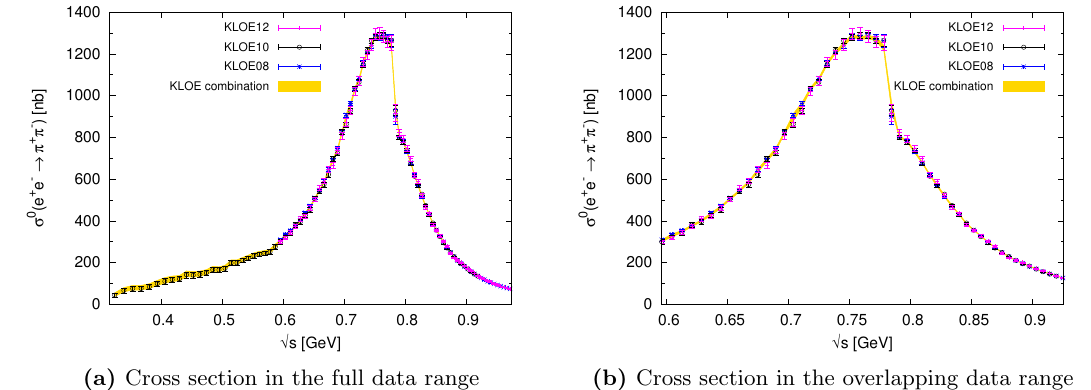
(b) Cross section in the overlapping data range Figure 4. The KLOE combination plotted with the individual cross section measurements, where the KLOE combination is represented by the yellow band and the KLOE08, KLOE10 and KLOE12 cross section measurements are given by the blue, black and pink markers, respectively (colour online). In all cases, the error bars shown are the statistical and systematic uncertainties summed in quadrature.